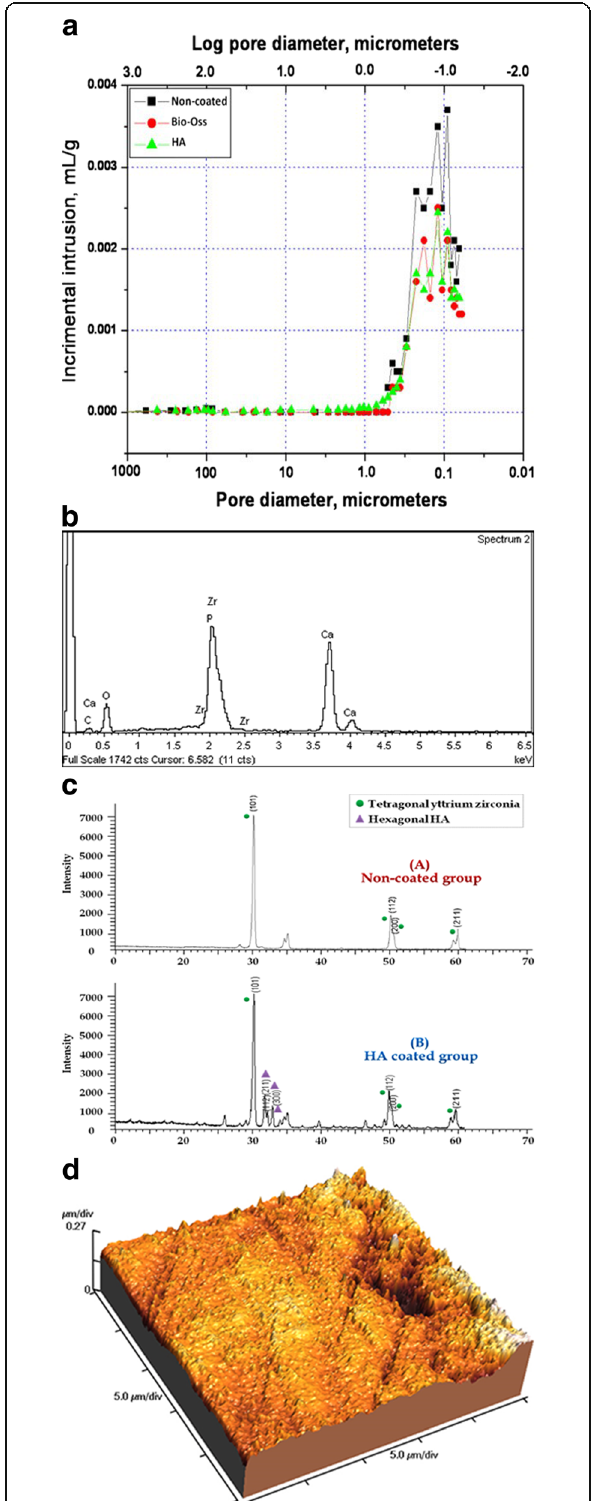
Fig. 1 a Mercury porosimetry and the average pore diameter of the prepared implants. b EDX analysis of hybrid – zirconia surface showing peaks of zirconia, calcium, and phosphate. Ca/P ratio is 1.67. c XRD peaks of uncoated and bioactive implants showing characteristic peaks specific for tetragonal yttrium zirconium oxide crystal system represented by (101), (112), (200), and (211) and hybrid implants showing characteristic peaks specific for hexagonal HA